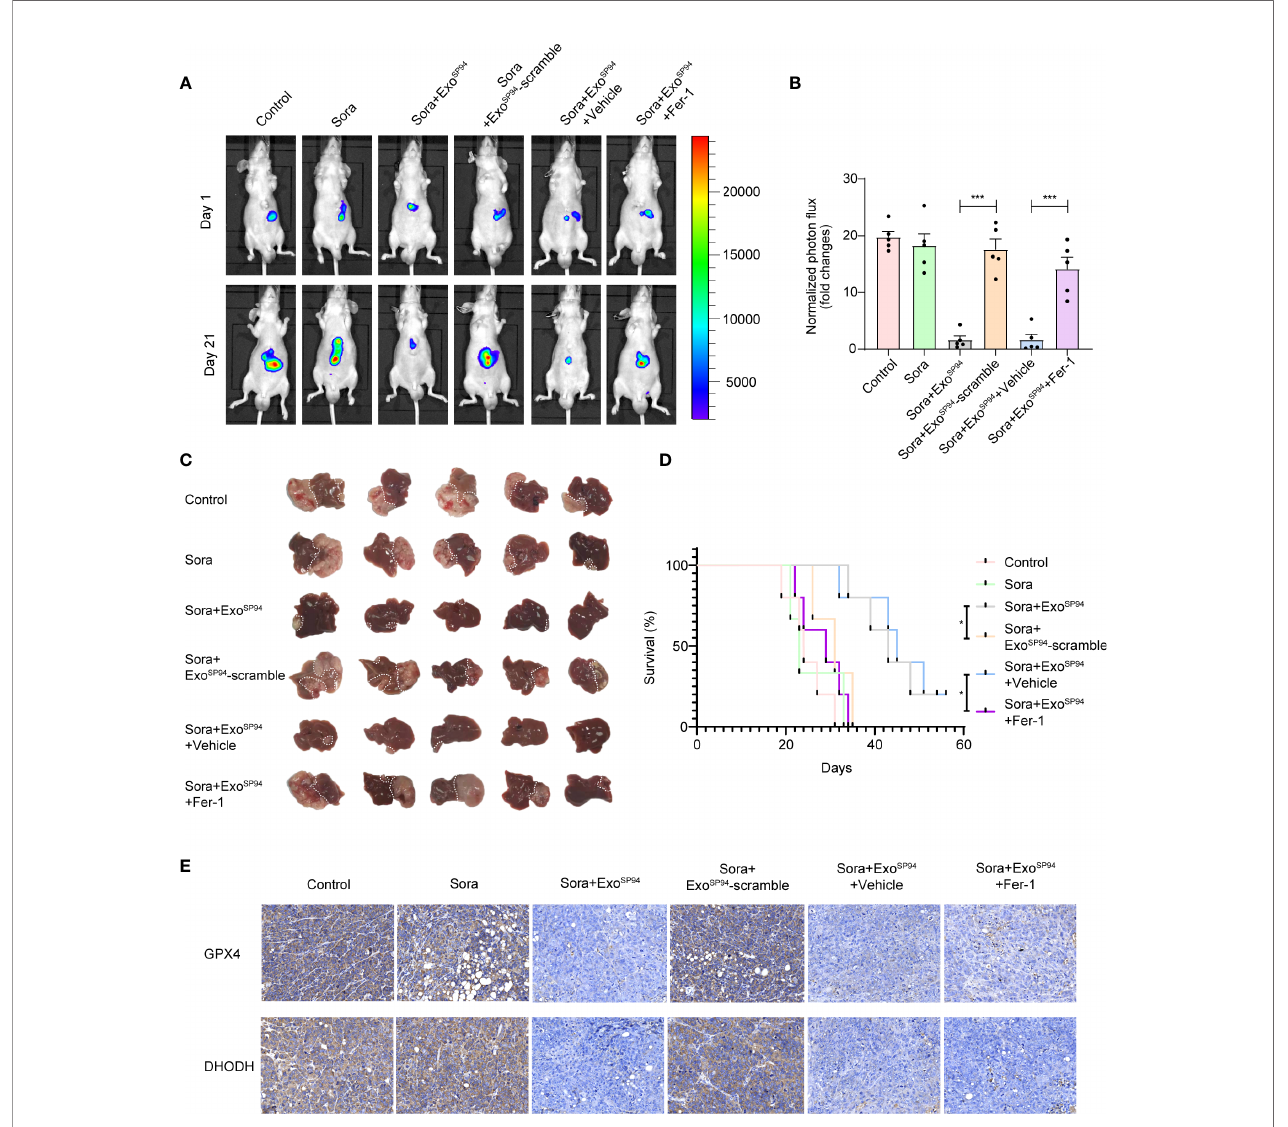
FIGURE 7 | Therapeutic effects of SP94-Lamp2b-RRM-functionalized exosomes and sorafenib in an HCC mouse model. Sorafenib-resistant HepG-2 cells were orthotopically injected into the left liver lobes of nude mice. Mice with a similar tumor size were used. Control: saline; Sora: sorafenib; Sora+Exo SP94 : sorafenib plus SP94- Lamp2b-RRM-functionalized exosomes containing multi-siRNA#1; Sora+Exo SP94 -scramble: sorafenib plus SP94-Lamp2b-RRM-functionalized exosomes containing scramble siRNA; Sora+Exo SP94 +Vehicle: sorafenib plus SP94-Lamp2b-RRM-functionalized exosomes containing multi-siRNA#1 in vehicle; Sora+Exo SP94 +Fer-1: sorafenib plus SP94- Lamp2b-RRM-functionalized exosomes in multi-siRNA#1 combined with ferrostatin-1. Tumor growth was measured with an IVIS imaging system. (A) Representative tumor imaging on days 1 and 21 after the fi rst treatment. (B) The normalized photon fl ux at day 21 was analyzed (n=5). (C) Image of resected xenografts of nude mice injected intrahepatically with Sorafenib-resistant HepG-2 cells. (D) Survival of mice from different groups (n=5). (E) Representative immunohistochemical staining for GPX4 and DHODH in HCC tissues from different groups (scale bar, 25 m m). (B) The data are shown as the means ± S.E.M. ANOVA with Dunnett ’ s t -test. (D) Log-rank test. *** p <